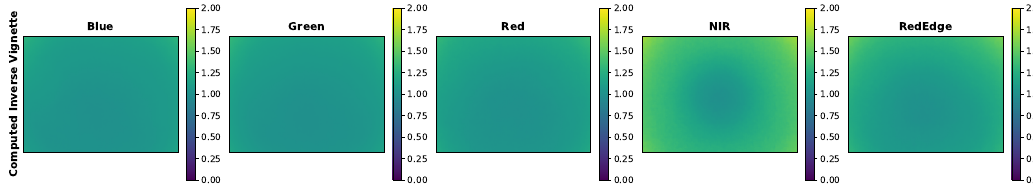
Figure 15. Inverse of example proposed vignettes. Proposed methodology divides the image by the vignette, while MicaSense method multiples. These images were produced to showcase the similarity between MicaSense and proposed